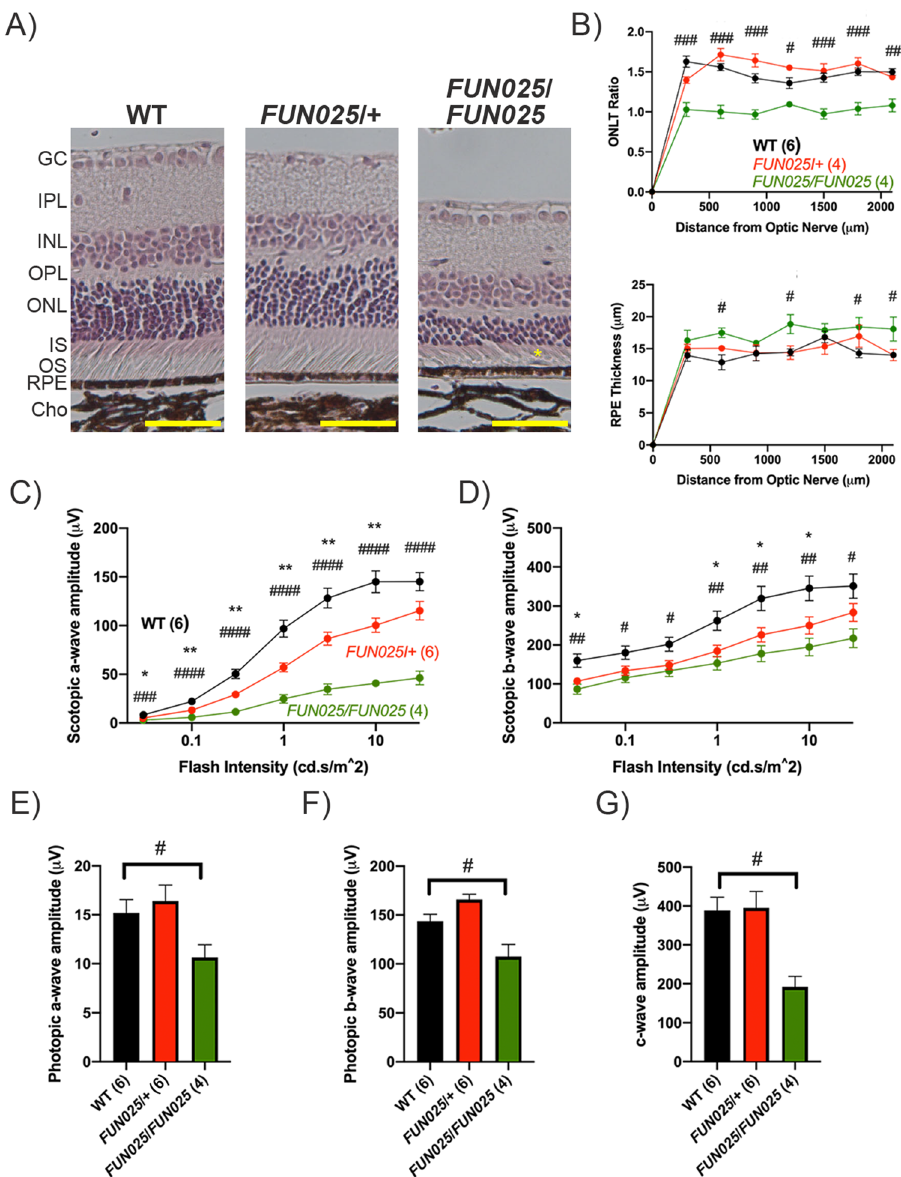
Figure 1. Retinal Phenotype of 12-Month-Old Tmem135 FUN025 / + mice. ( A ) Representative images of the retinas of 12-month-old WT, Tmem135 FUN025/ + ( FUN025/ + ) and Tmem135 FUN025/FUN025 ( FUN025/FUN025 ) mice. Note the decreased ONL thickness and subretinal immune cell (denoted with a yellow asterisk) in the 12-month-old Tmem135 FUN025/FUN025 retina which are not present in the 12-month-old Tmem135 FUN025/ + mice. Magnification = 20×. Scale bar = 100 microns. ( B ) ONLT and RPE ratios. No significant differences were noted between the WT and Tmem135 FUN025/ + mice. ( C-G ) ERG recordings for 12-month-old WT, Tmem135 FUN025/ + and Tmem135 FUN025/FUN025 mice during scotopic and photopic conditions. * and ** indicates a P < 0.05 and P < 0.01 significance by post hoc Tukey test following a significant difference detected by one-way ANOVA between WT and Tmem135 FUN025/ + . # , ## , ### , and #### indicates a P < 0.05, P < 0.01, P < 0.001, and P < 0.0001significance by post hoc Tukey test following a significant difference detected by one-way ANOVA between WT and Tmem135 FUN025/FUN025 mice. All data are mean ±